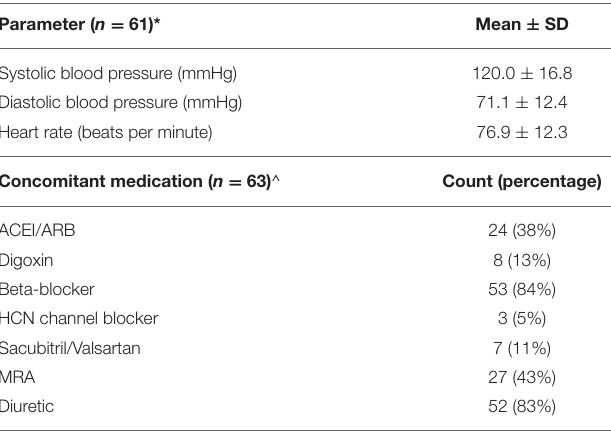
TABLE 4 | Baseline systemic blood pressure, heart rate, and concomitant medications for heart failure patients. Parameter ( n =